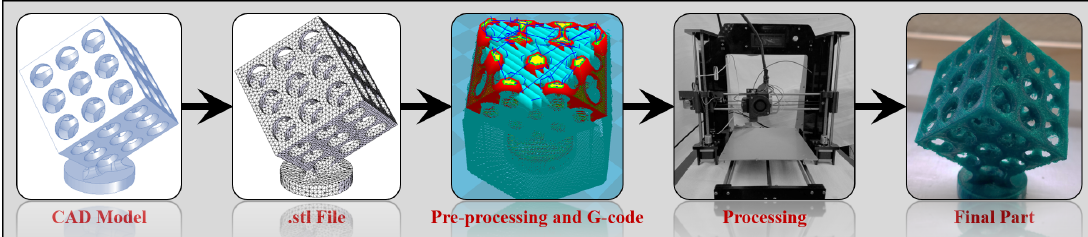
Figure 1. AM concept map.